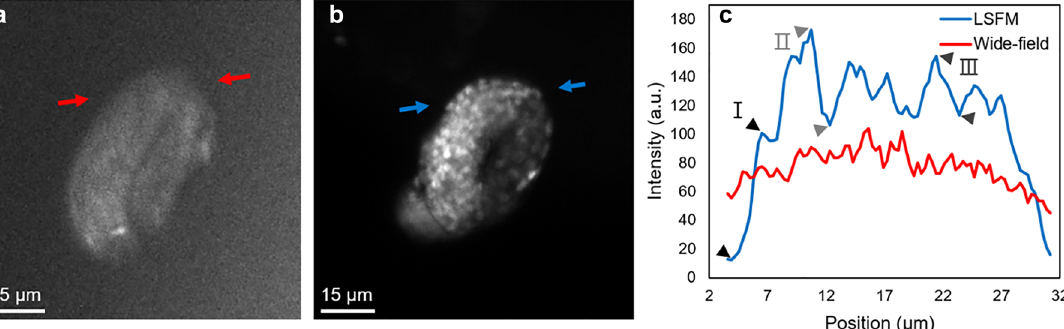
Figure 5: In vivo fl uorescence images of developing embryos. (a)Wide- fi eld fl uorescenceimageoftheembryo.(b)LSFMimageoftheembryoimmobilizedinagar.(c)Intensitycross-sectionsalongthelines plotted in (a) and (b), respectively. I, II, and III indicate three different locations inside the embryos with a contrast value of 77, 24, and 15% tively. (a) and (b) are shown in the same scale (time-lapse video can be found in supplementary